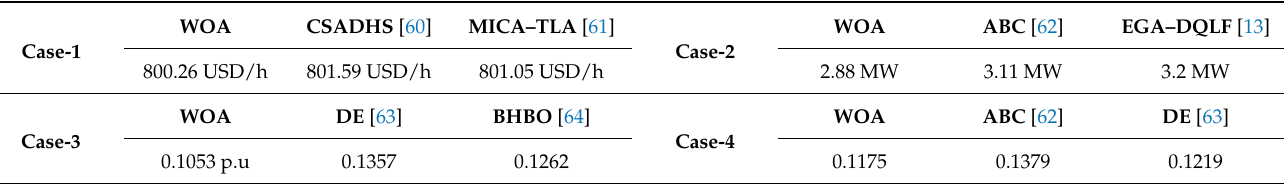
Table 6. Comparison of SOF based OPF achieved by various optimization